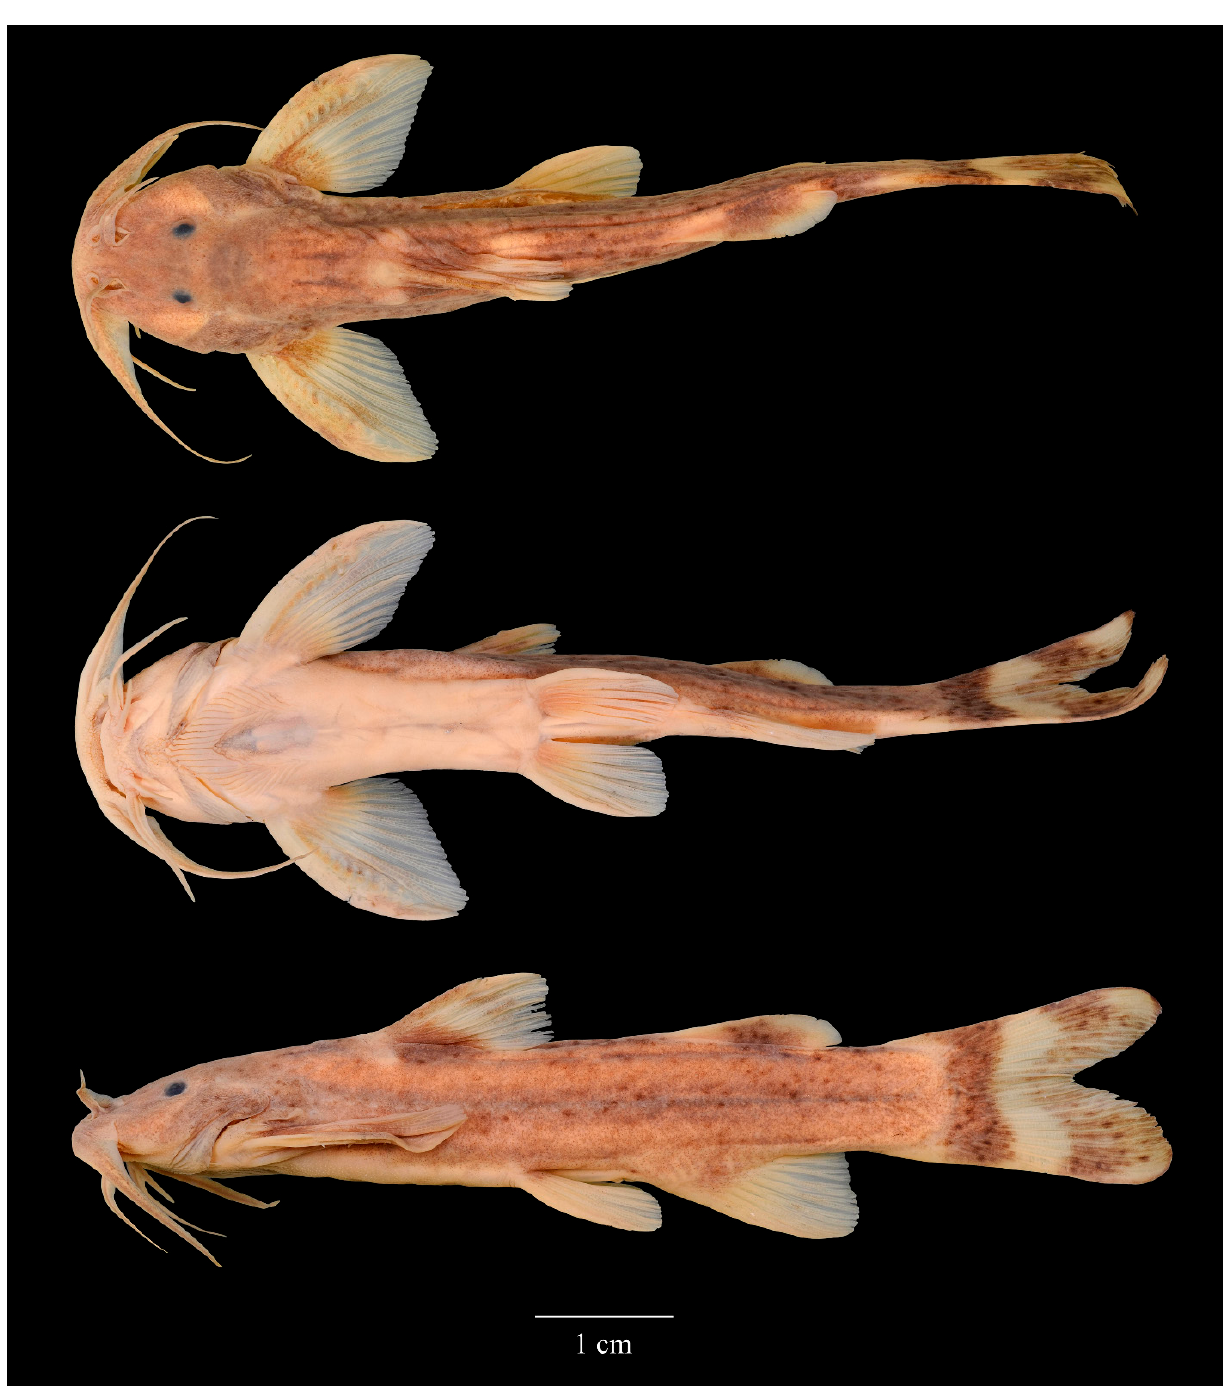
Figure 7. Glyptothorax silviae , CMNFI 1979-0390A, 67.6 mm SL, holotype; Iran: stream 3 km south of Bagh`e Malek, Persian Gulf basin.